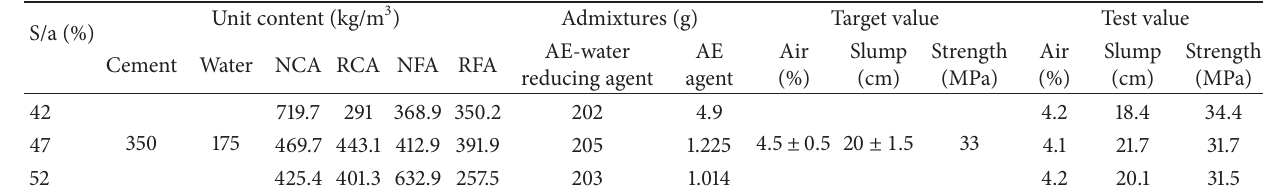
Table 4: Criteria